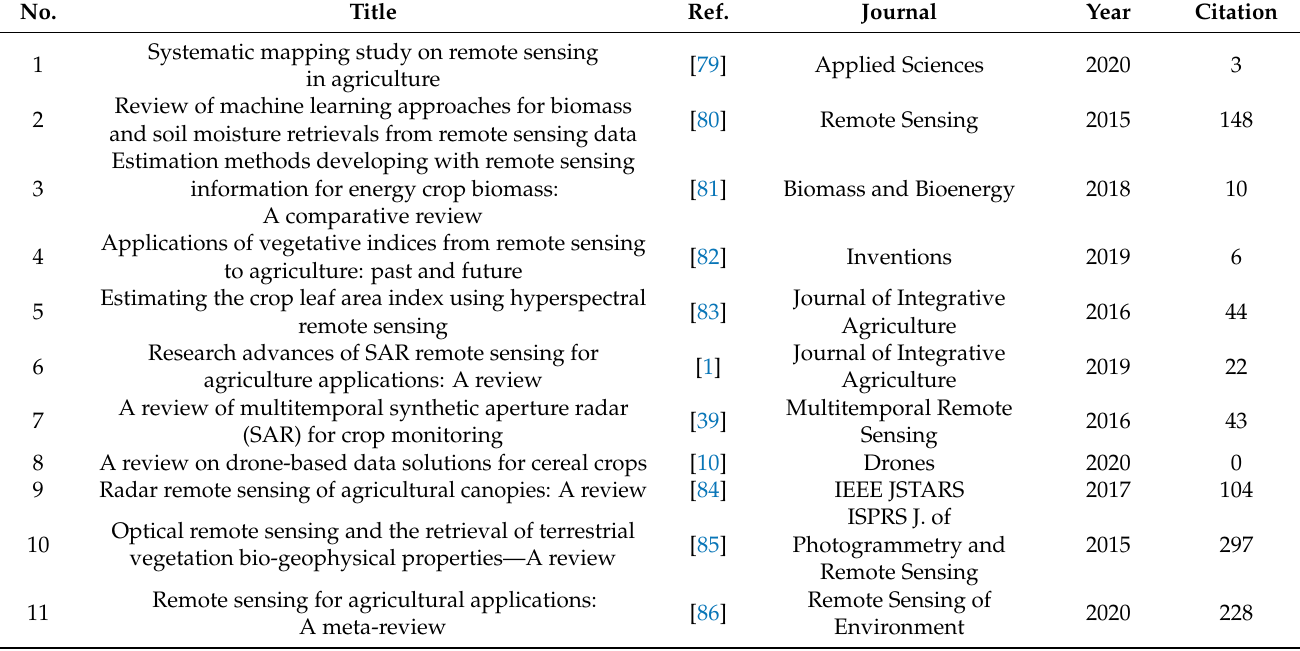
Table 1. Review studies on crop parameter estimation and remote sensing